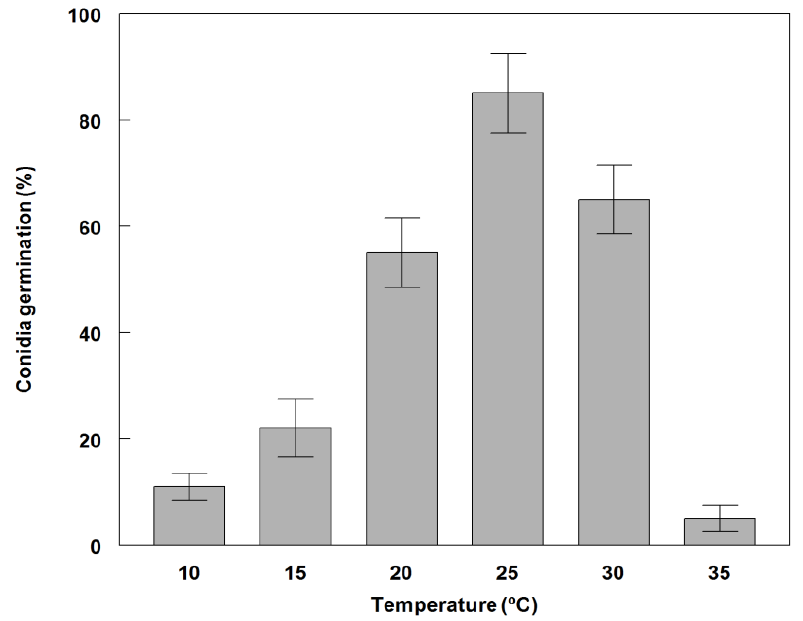
Figure 2. Effect of temperature on germination of conidia of P. commelinicola on PDA, 7 days after inoculation and growth under alternating light/dark conditions (12 h light/dark at 28 °C). Error bars represent Fisher’s LSD ( p =